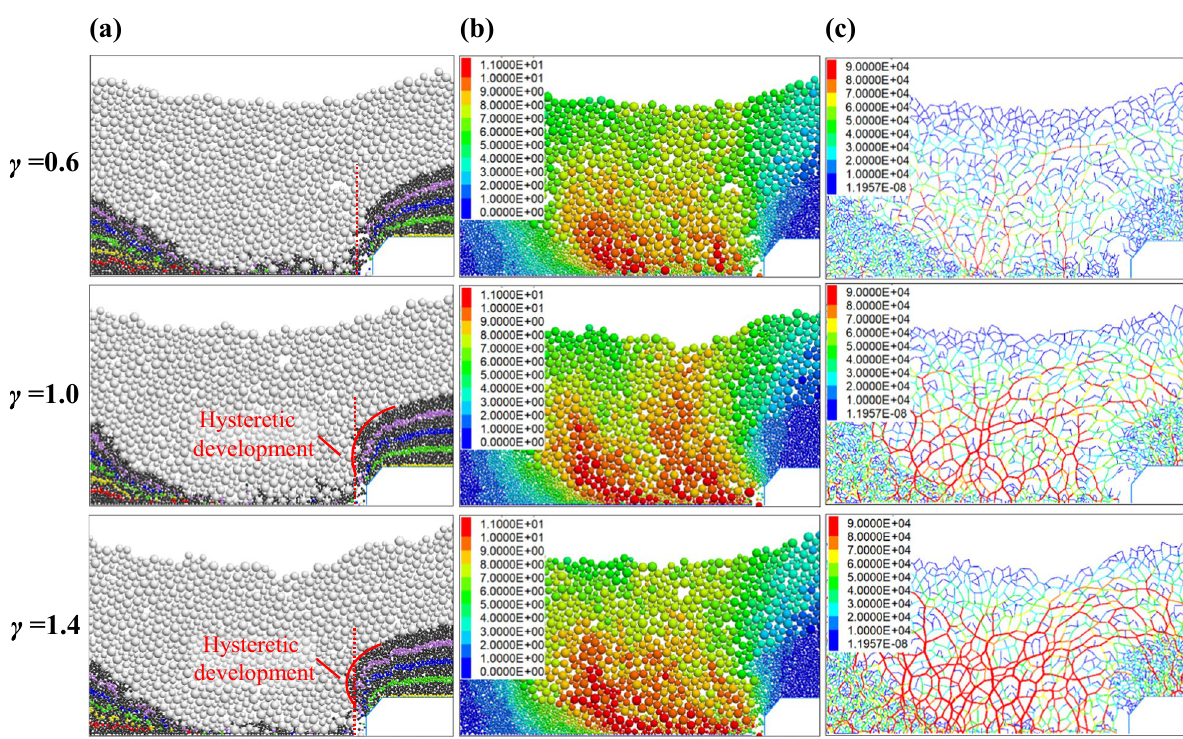
Fig. 19 a Shape of the boundary; b Displacement field diagram (unit: m); and c Force chain diagram (unit: N) in the normal cycling stage for different